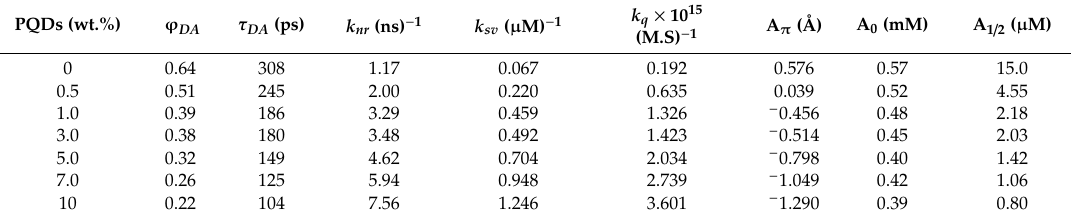
Table 1. Optical properties of the PFO / MEH-PPV hybrid thin film with various PQD contents. PQDs (wt.%) ϕ DA τ DA